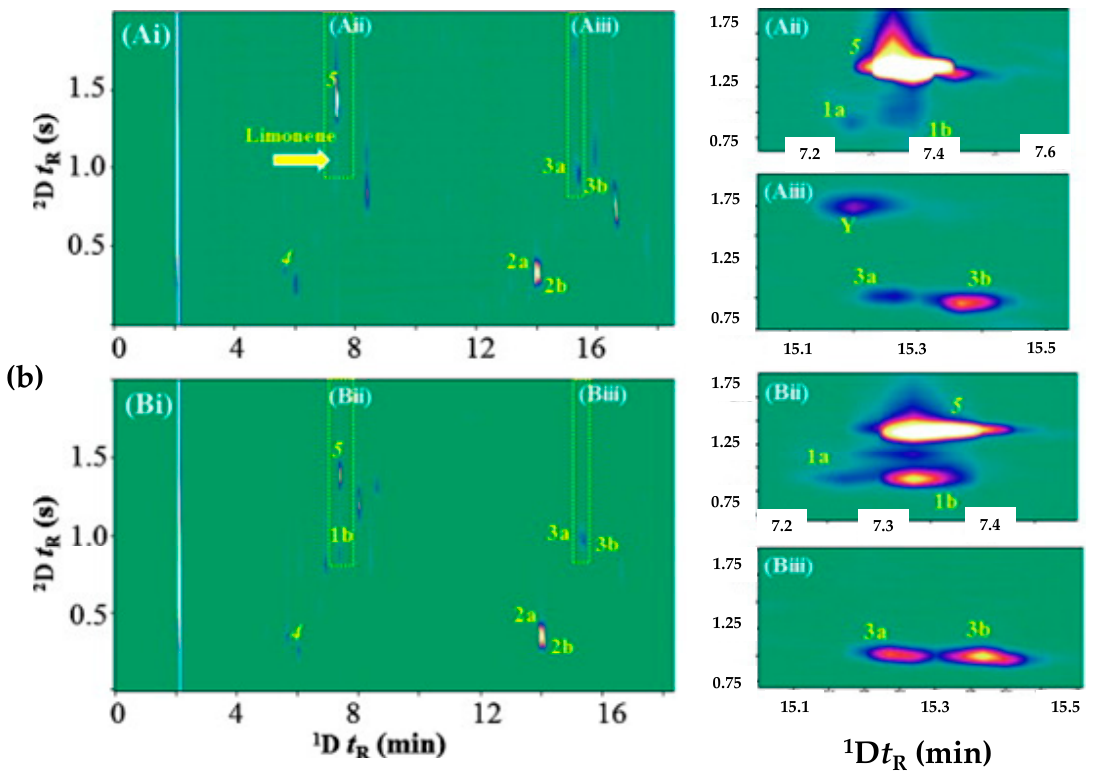
Figure 7. eGC × GC-FID contour plots of two TTO samples P1 ( a ) and C6 ( b ), and the expansion of rectangle region of limonene (Aii and Bii) and α -terpineol (Aiii and Biii) in TTO of samples P1 and C6, respectively. Components: 1(a), ( − )-limonene; 1(b), (+)-limonene; 2(a), (+)-terpinen-4-ol; 2(b), ( − )-terpinen-4-ol; 3(a), ( − )- α -terpineol; 3(b), (+)- α -terpineol; 4, α -pinene; 5, p-cymene; Y, unknown compound. Reprinted from [94].